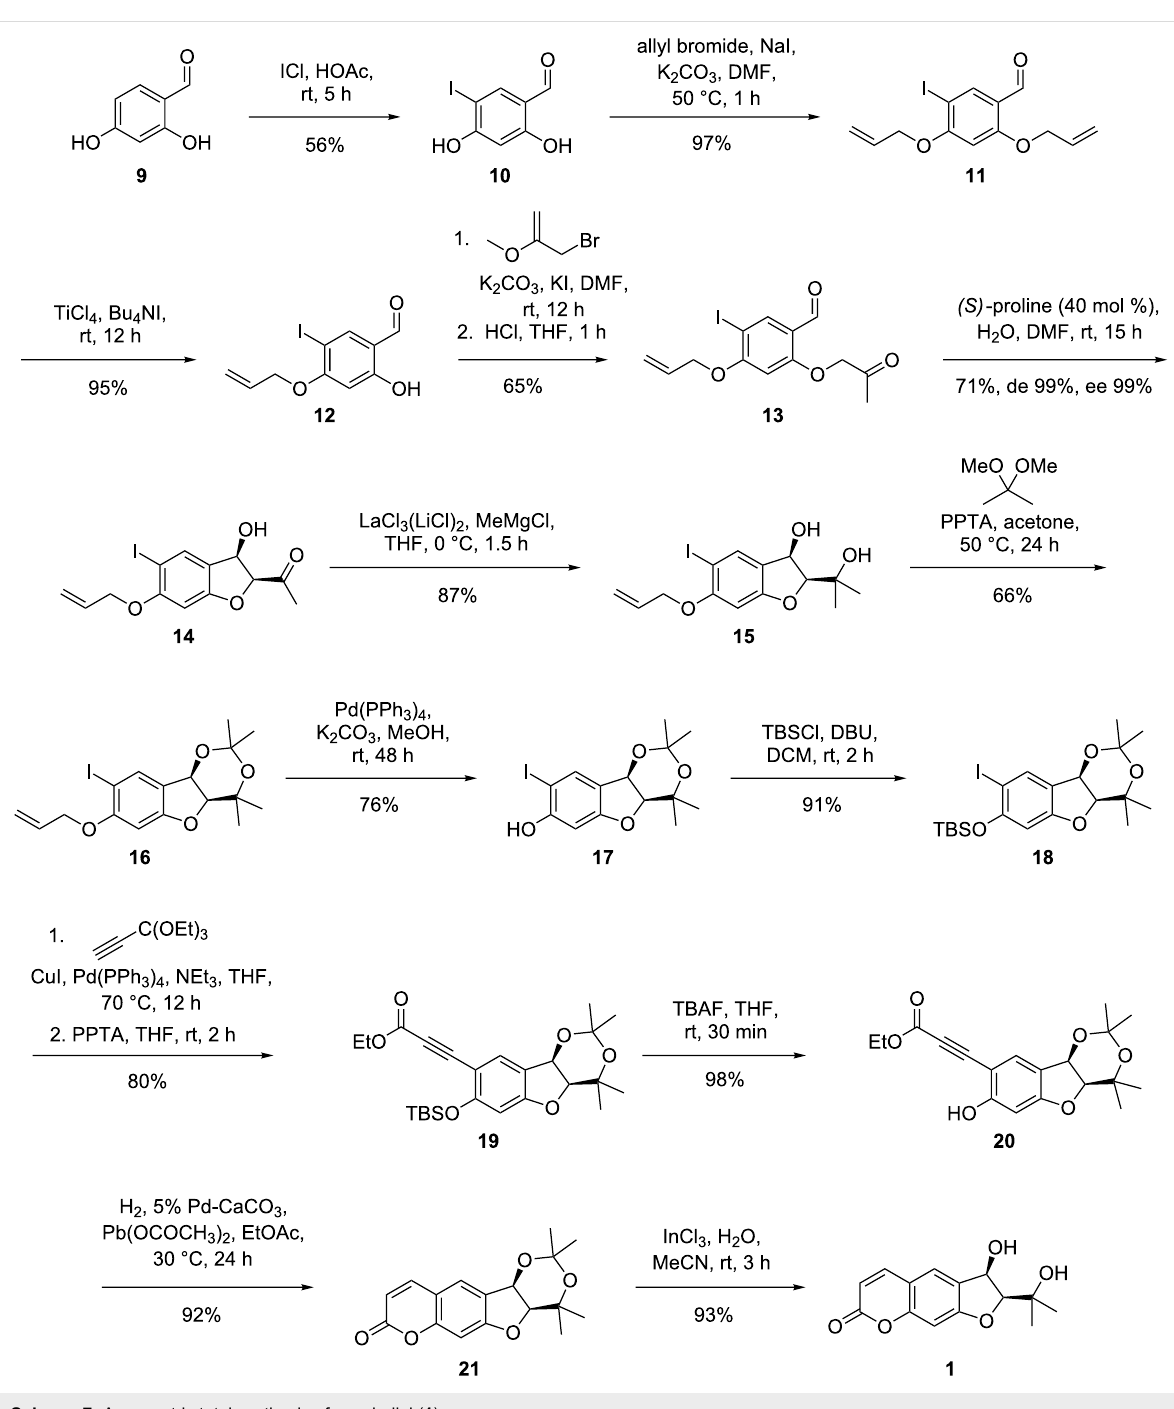
Scheme 7: Asymmetric total synthesis of smyrindiol ( 1 ).